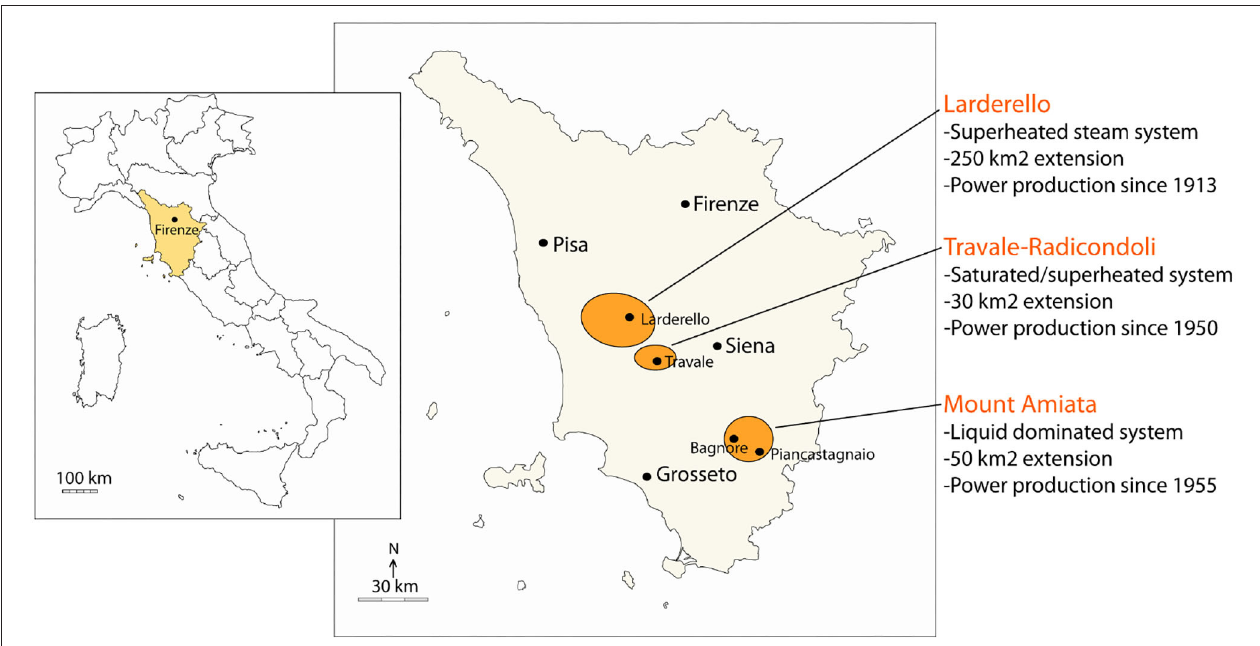
FIGURE 1 | Location of the geothermal areas where electrical power is produced in Tuscany [modified from Manzella et al. (2018)].